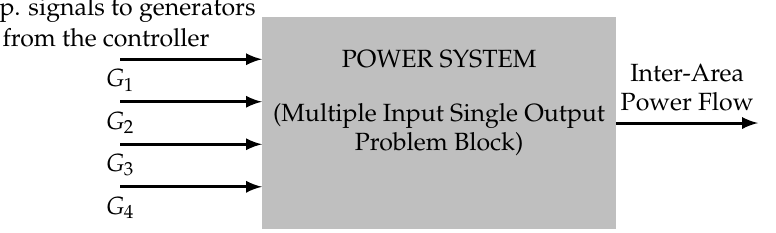
Figure 7. Multiple Input Single Output (MISO) representation of the power system.